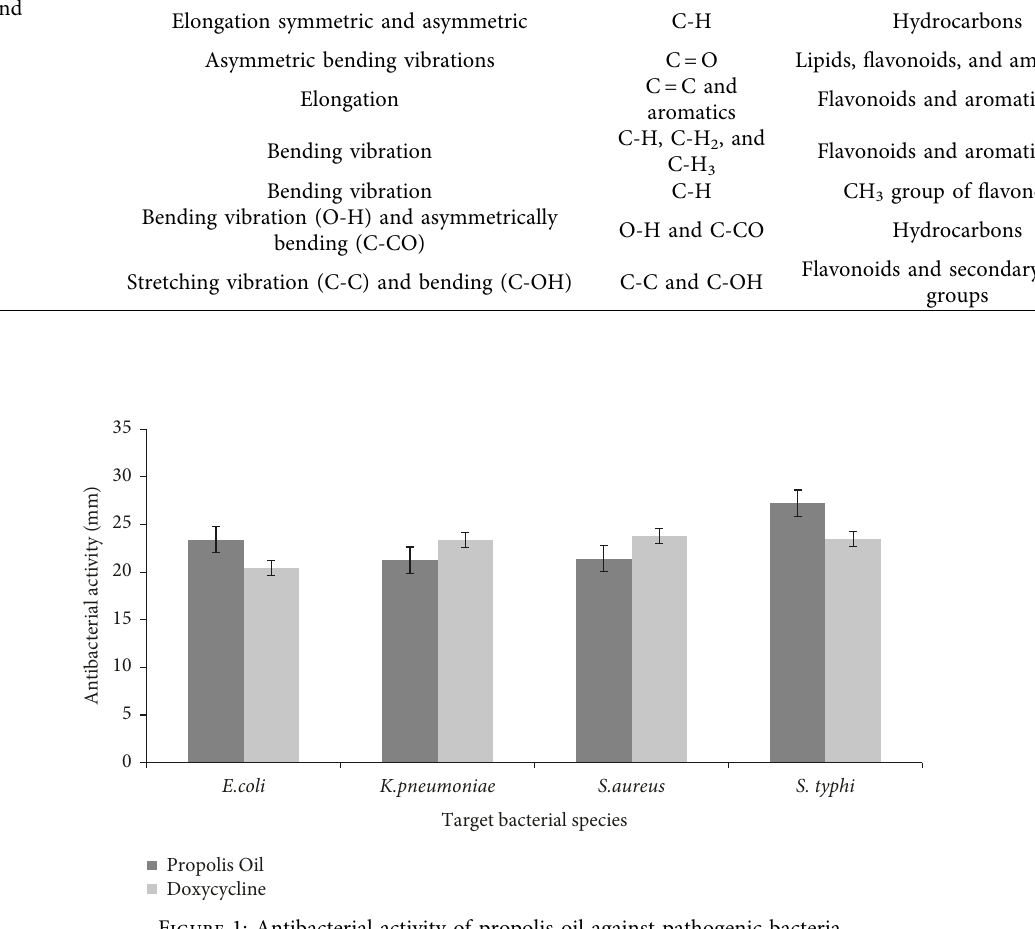
Figure 1: Antibacterial activity of propolis oil against pathogenic bacteria.